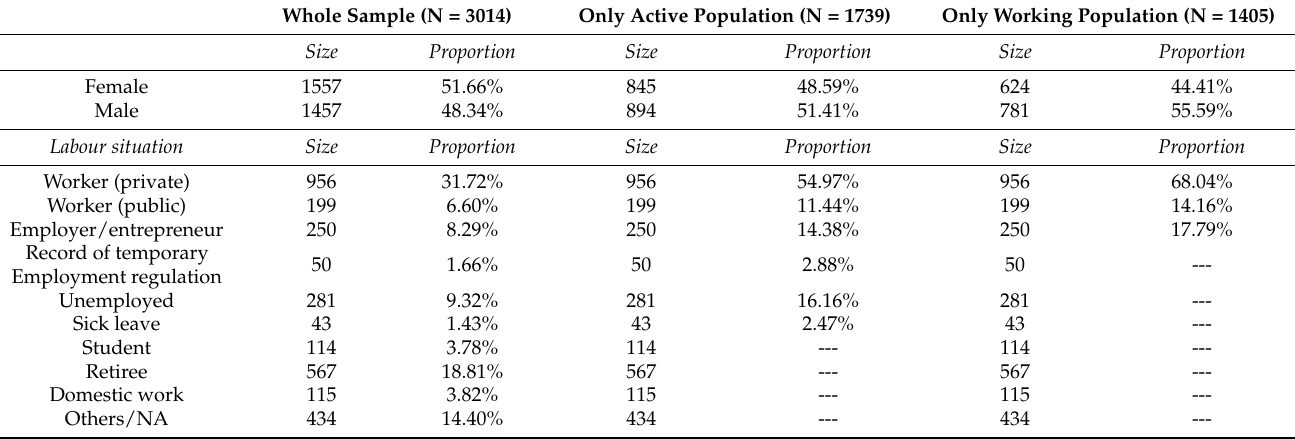
Table 1. Gender and working situation in the sample and subsample used in this paper.